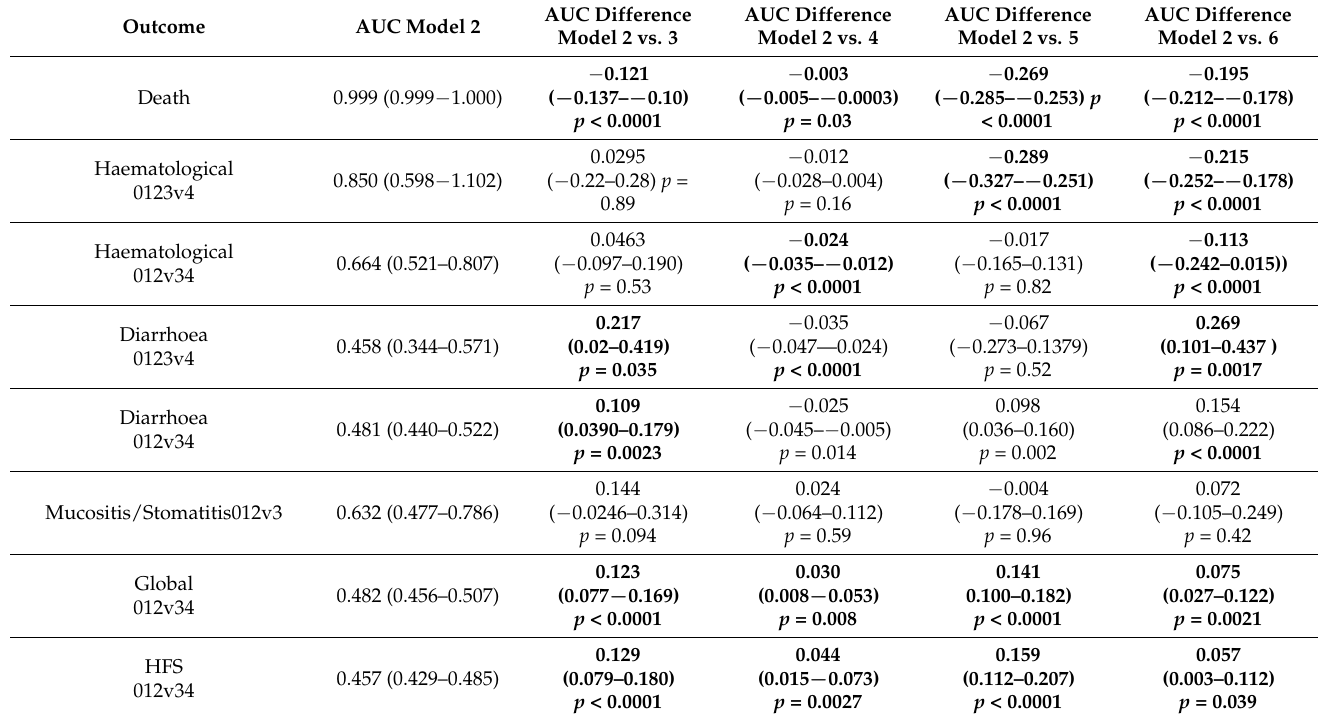
Table 2. Comparison of model 2 (DPYD deficiency alleles detected in QUASAR 2) to models additionally including a common variant previously shown to be associated with 5-FU toxicity.